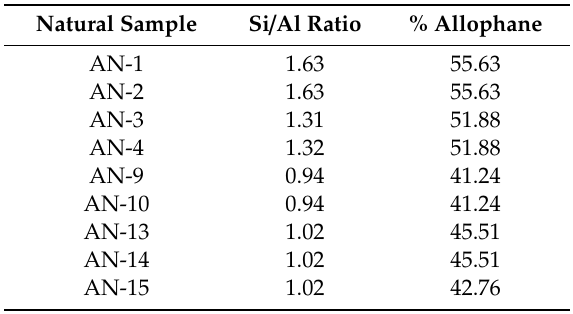
Table 8. Results of the ratio of Si / Al and % of allophane in natural